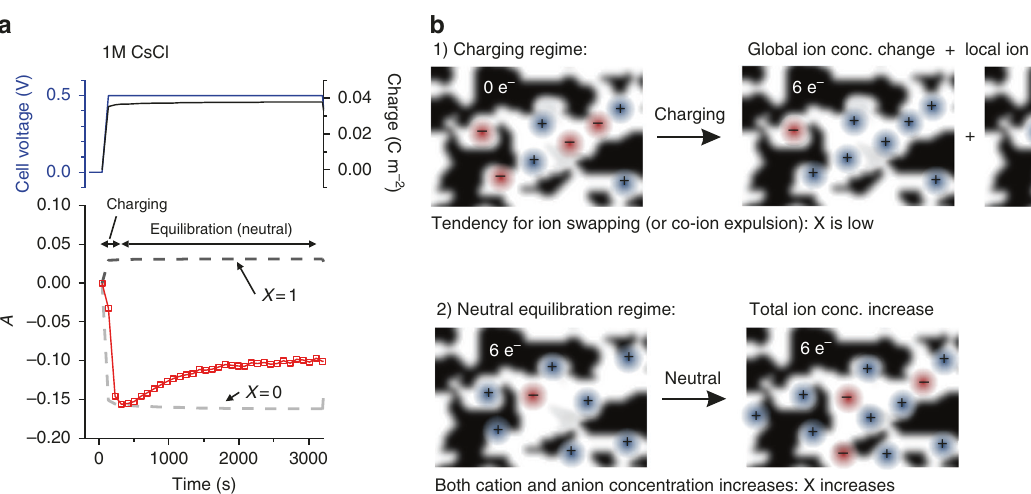
Fig. 4 Two distinct time regimes of ion concentration changes. a Relative attenuation A (red data points), applied cell voltage U (blue) and charge Q (black) vs. time are shown exemplarily for a single chronoamperometry charging step at + 0.5 V (left) for 1 M CsCl. The gray and the black dashed line indicate the theoretical attenuation curves for pure ion swapping ( X = 0) and pure counter-ion adsorption ( X = 1), respectively. As visualized on the right ( b ), ion concentration changes can be separated in two processes occurring at signi fi cantly different time scales: a fast charging regime with ion swapping as the main charging mechanism (recorded by in situ X-ray transmission, XRT) in combination with local ion rearrangement (recorded by in situ small angle X-ray scattering, SAXS) and a subsequent neutral increase of the total ion concentration (recorded by in situ XRT) causing a slow transition towards